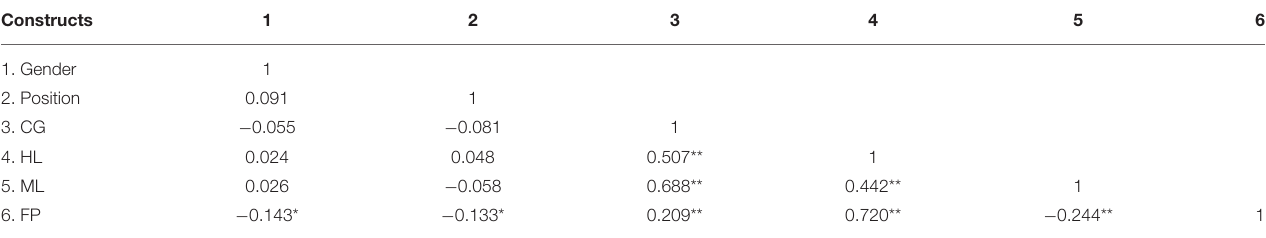
TABLE 4 | Correlation analysis.